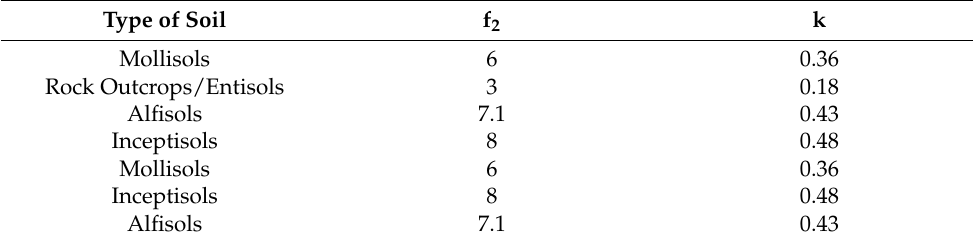
Table 2. Soil factor